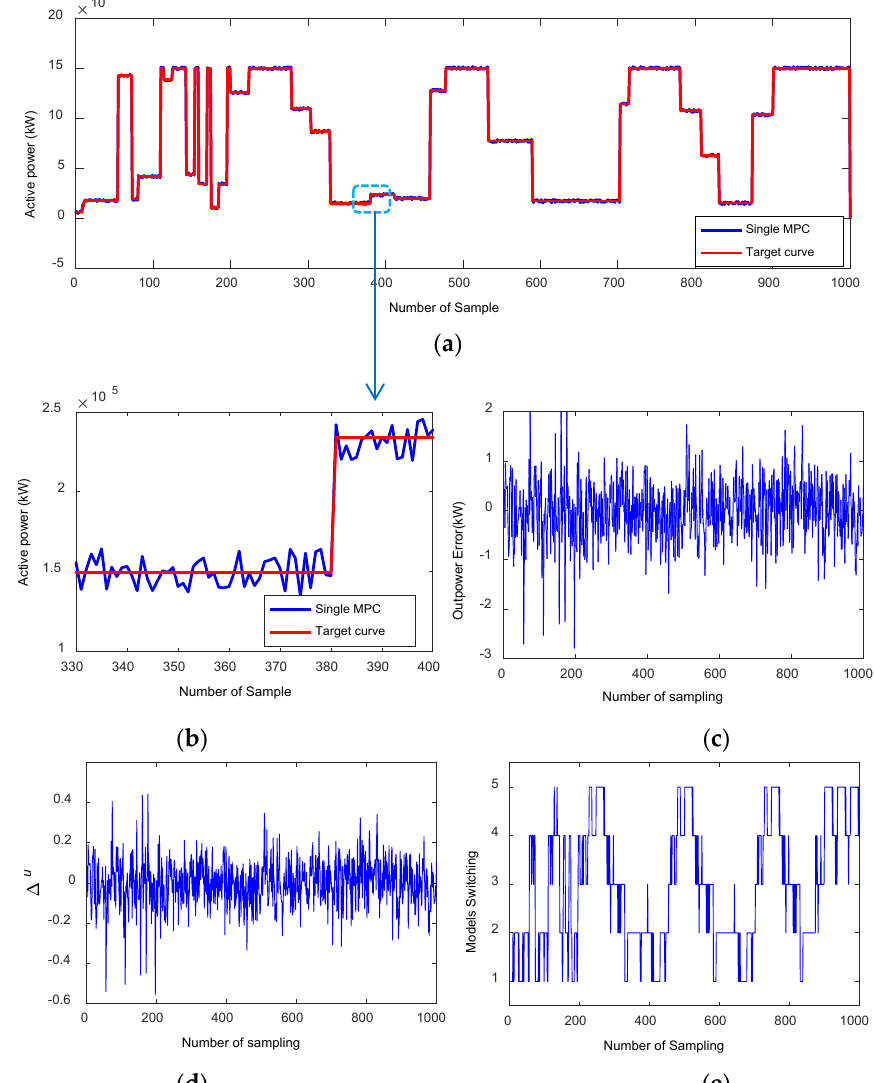
Figure 3. Simulation results using the single model predictive control (MPC). ( a ) The output power of wind farm using a single MPC; ( b ) Local zoom of ( a ), ( c ) output power error between target curve and control output, ( d ) control incremental of the single MPC, ( e ) model selection during the control